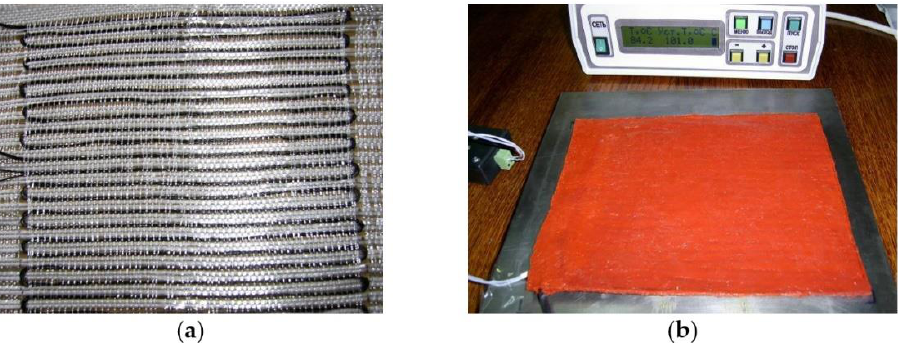
Figure 14. Resistive layer based on carbon thread and fiberglass ( a ) and flexible thermal blanket ( b ).